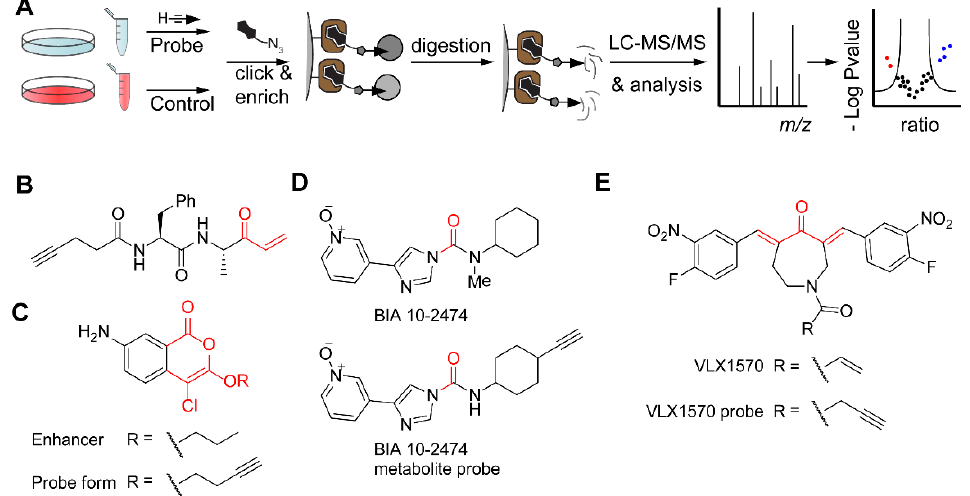
Figure 7. Target identification in ABPP by making use of bioorthogonal chemistry. ( A ) Schematic overview of a general workflow for target identification of ABPs. Live cells or a cell lysate are treated with a clickable probe. Recommended is a control experiment without a probe or with a competitive inhibitor. After cell lysis, CuAAC with a biotin-tagged reagent, and enrichment on immobilized streptavidin (in brown), tryptic digestion yields peptides for LC-MS / MS analysis and data processing, for example by volcano plot, as depicted. Note 1: the control experiment can be isotopically labeled, e.g., by SILAC (stable isotope labeling by amino acids in cell culture) or tryptic peptides can be labeled with heavy and light isotope labels before mixing. Alternatively, label-free quantification can be used. Note 2: Proteins may also be eluted prior to digestion in order to identify the modified peptide. Alternatively, after ‘on bead’ digestion, the modified peptide may be released by making use of, for example, a cleavable linker. ( B ) Alkyne-tagged ABP based on an inhibitor of attachment and invasion of the Toxoplasma parasite. The reactive electrophile is shown in red. ( C ) Structure of an enhancer of Toxoplasma invasion into host cells and an alkynylated derivative with the reactive electrophile in red. ( D ) Structure of FAAH inhibitor BIA 10-2474 and a probe derived from a de-methylated metabolite (electrophilic carbonyl in red). ( E ) Structure of DUB inhibitor VLX1570 and an alkyne-tagged probe form. Note that the two Michael acceptor systems (in red) can lead to crosslinking of proteins.